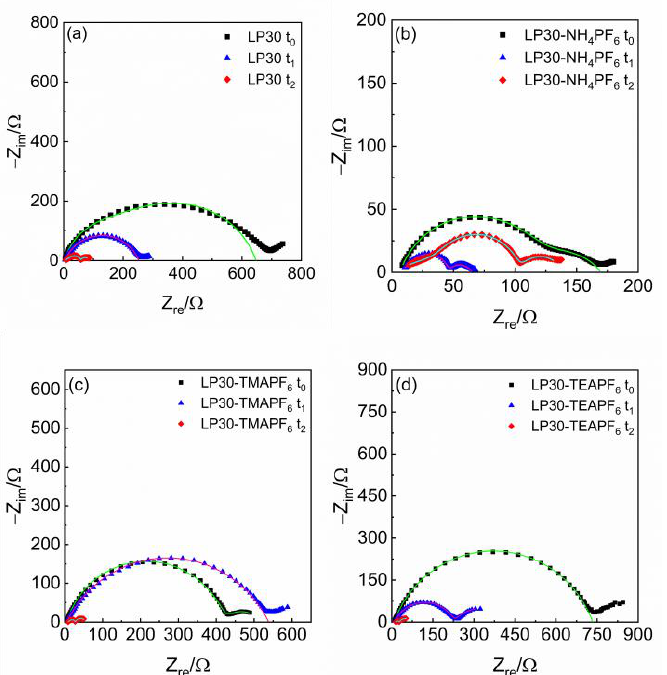
Figure 5. Electrochemical impedance spectra of Li||Li symmetric cells ( a ) LP30, ( b ) LP30-NH 4 PF 6 , ( c ) LP30-TMAPF 6 , ( d ) LP30-TEAPF 6 after different cycling time. The green, red and cyan lines in the